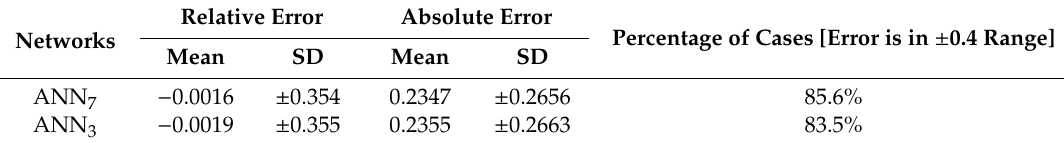
Table 6. Mean error between PMV calculated according to ISO 7730 (PMV standard ) and the one simulated by ANN (ANN 7 and ANN 3 ).